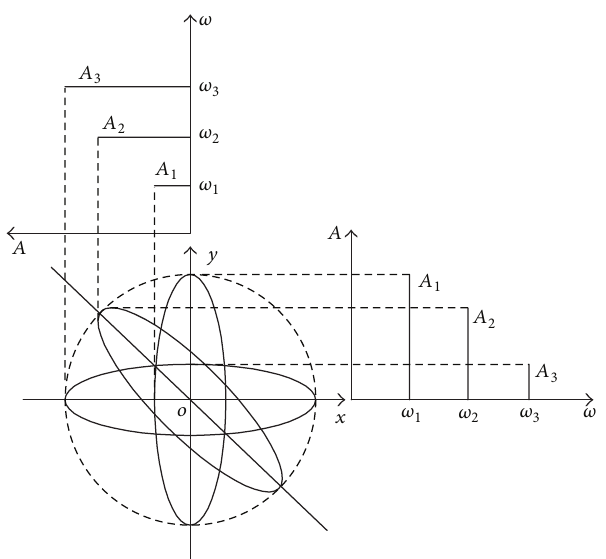
Figure 3: Spectrum structure error of transducers in different